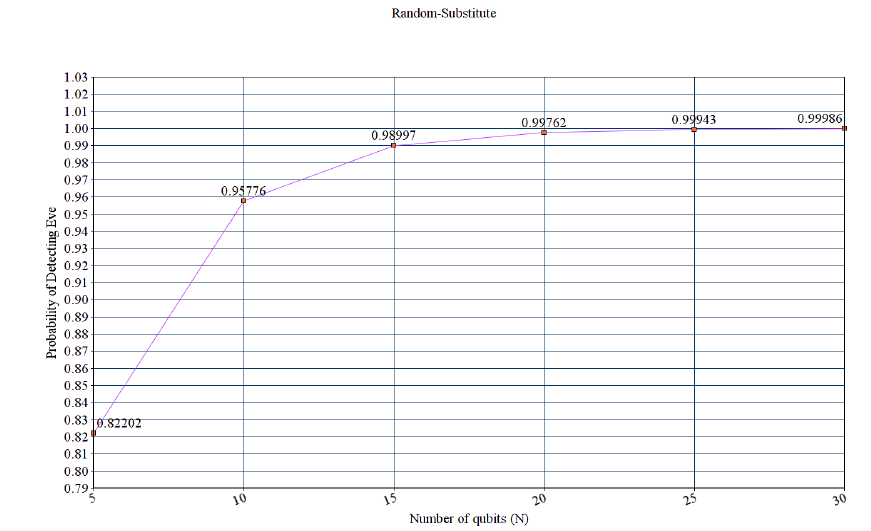
Figure 9. Probability of detecting Eve during Random Substitute